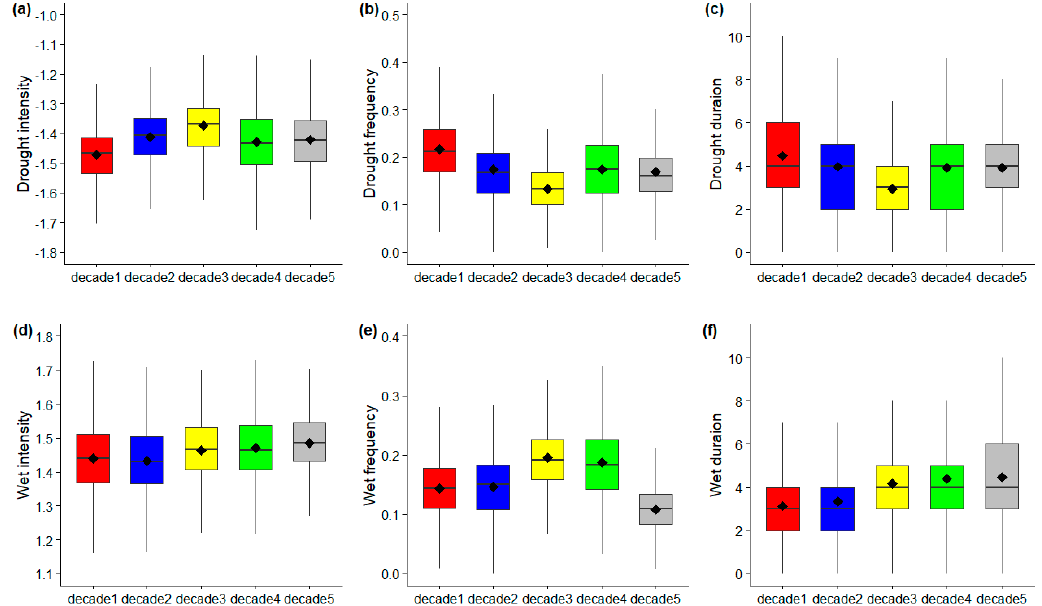
Figure 7. Temporal variation in the drought and wetness intensity ( a , d ), frequency ( b , e ), and duration ( c , f ) across China for the periods from 1965 to 1974 (decade1), 1975 to 1984 (decade2), 1985 Table 1994. (decade3), 1995 to 2004 (decade4), and 2005 to 2017 (decade5), respectively. For each box, the central black line is the median, the black square point is the average, the upper and bottom edge of the box correspond to the 25th and 75th percentiles, and the whiskers show the range of the